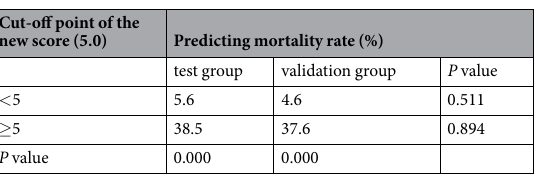
Table 6. The cut-off point of the new scores for predicting cumulative AKI and mortality rates at 90-day after AKI